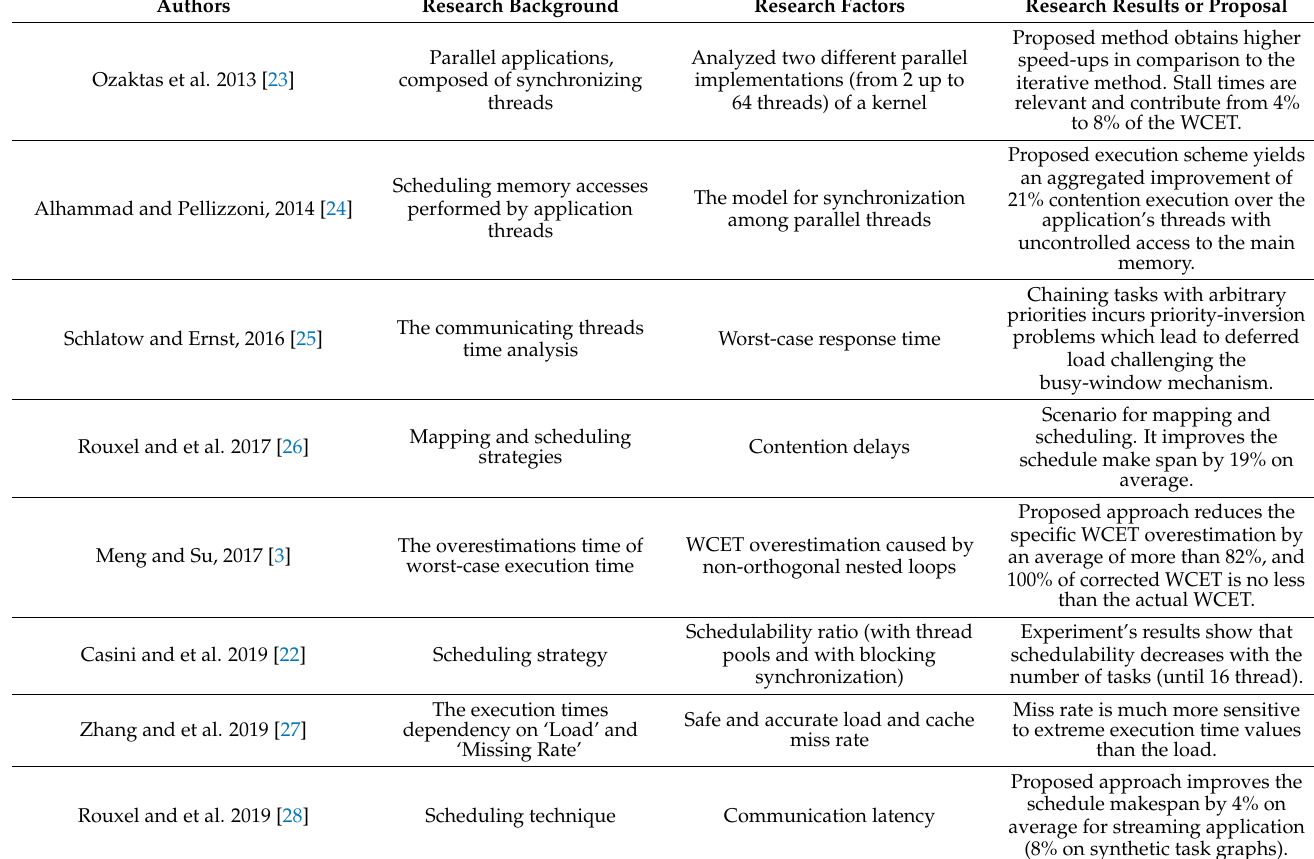
Table 1. Summary of worst-case execution time (WCET) estimation-related research